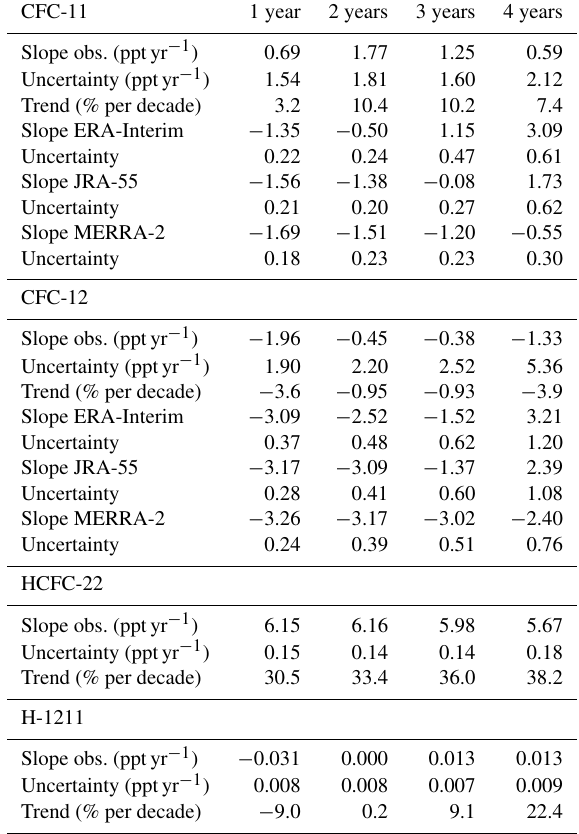
Table 2. Temporal trends and their 2 σ uncertainties of CFC-11, CFC-12, HCFC-22, and H-1211 mixing ratios at AoAs of 1, 2, 3, and 4 years. These slopes correspond to an uncertainty-weighted regression line fitted to the data in Figs. 3, and S8–S12, with two exceptions: (1) the data from the Asian monsoon campaign in 2017 was excluded as this region is not representative of northern hemispheric stratospheric air and (2) all data at mean ages above 3.5 years from winter campaigns in high latitudes were also ex- cluded as they might contain polar vortex air, which is equally un- representative. Model-based slopes were derived over the same pe- riod as observational data (August 2009–August 2018), except for JRA-55 and MERRA-2, where data were only available until the end of